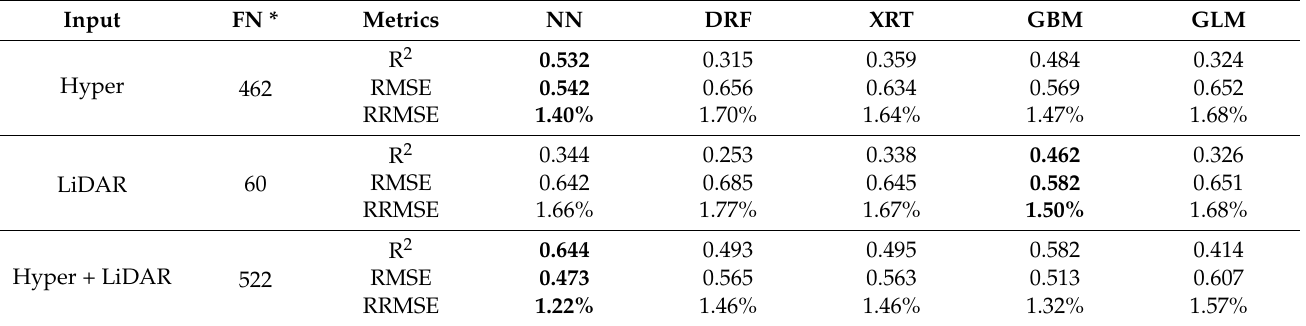
Table 6. Validation statistics of soybean protein concentration estimation using five/different Au- toML